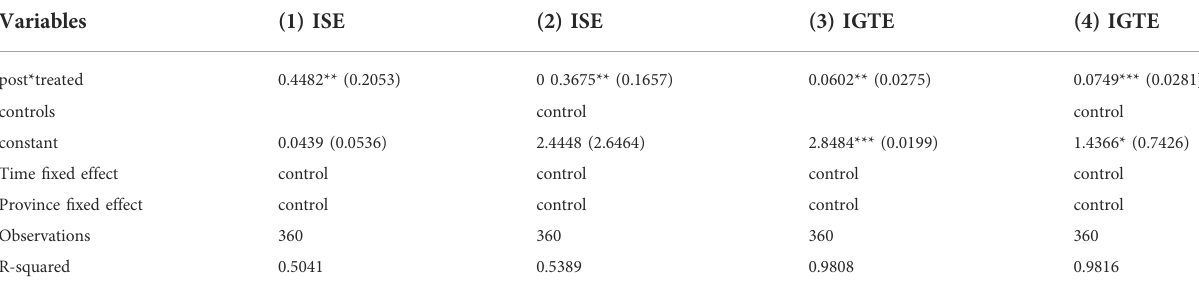
TABLE 4 Robustness test: change the time window width.